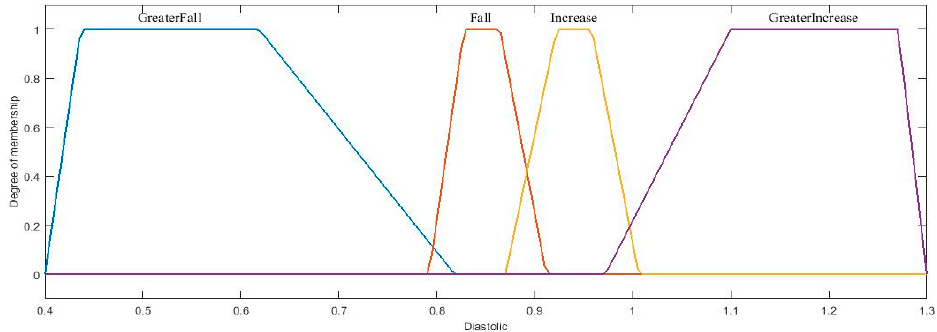
Figure 18. Optimized systolic quotient input.